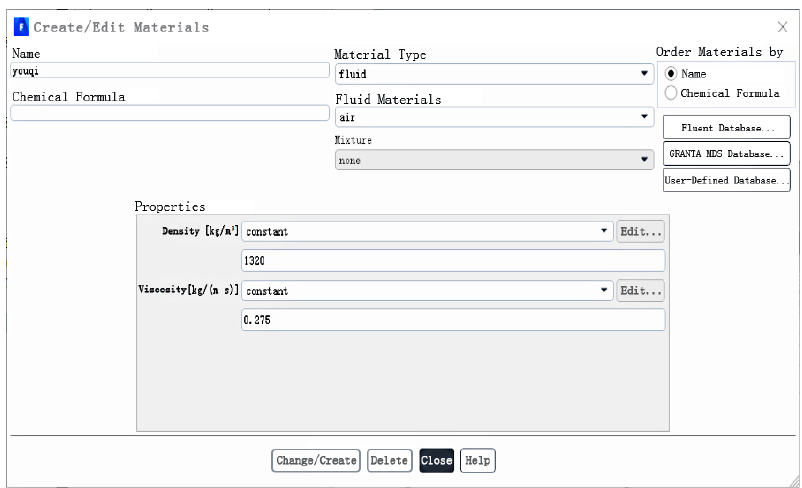
Figure 10. Material settings dialog.